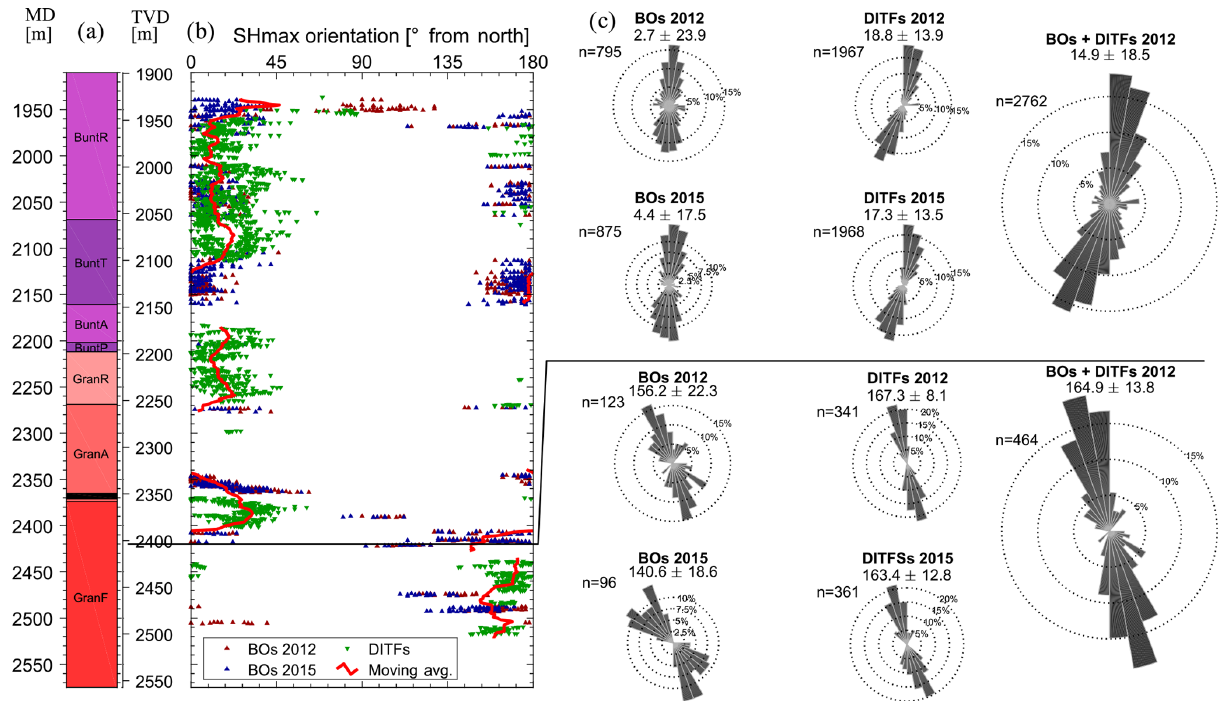
Figure 11. Evolution in the orientation of the maximum principal stress as a function of measured depth (MD) and vertical depth (TVD) in GRT-1 in 2012 and 2015. (a) Simplified lithologies along the GRT-1 borehole (see Fig. 8 for the legend). (b) Orientation of S H from the azimuth of the maximum radial extension of the breakouts (BOs) from the datasets of 2012 (in blue) and 2015 (in red) acquired in GRT-1. In green is the orientation of S H from the azimuth of drilling-induced tensile fractures (DITFs). The red line is a moving average of the orientation data. (c) Orientation in rose diagrams from the datasets displayed in panel (b) .